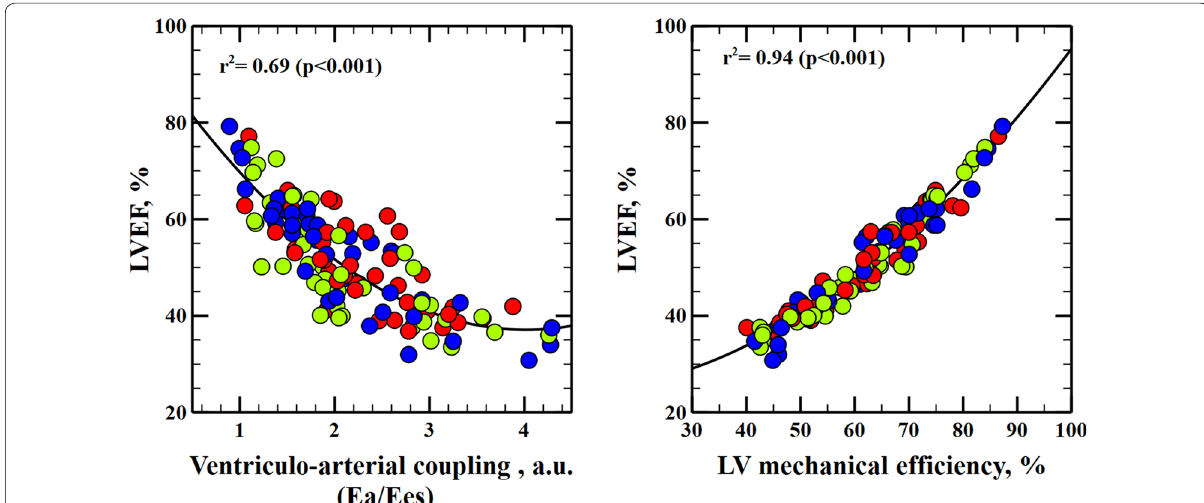
Fig. 1 Relationship between ventriculo-arterial coupling, left ventricular mechanical efficiency and left ventricular ejection fraction. Left: linear regression analysis between ventriculo-arterial coupling (VAC), calculated as the ratio between effective arterial elastance (Ea) and left ventricular end-systolic elastance (Ees), and left ventricular ejection fraction (LVEF). Right: linear regression analysis between left ventricular mechanical efficiency, calculated as the ratio between stroke work (SW) and the left ventricular pressure–volume area (PVA), and left ventricular ejection fraction. Colors inside circles represent different experimental interventions: red, afterload; green: preload; blue: contractility